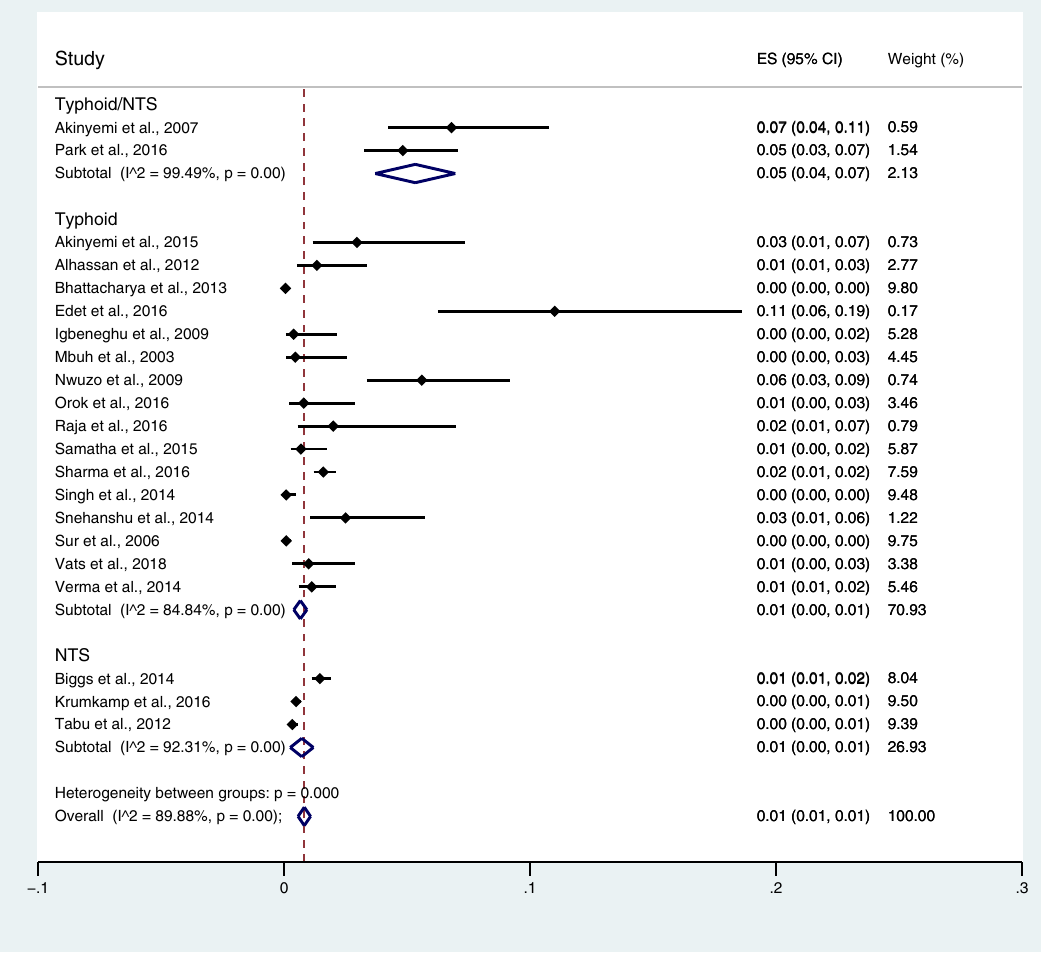
Figure 7. Pooled prevalence of typhoidal/NTS and malaria co-infection using blood cultures for the identification of Salmonella spp. infection stratified by typhoidal/NTS infection. ES proportion estimate (multiply 100 units for interpreted as prevalence estimate), CI confidence interval, NS not